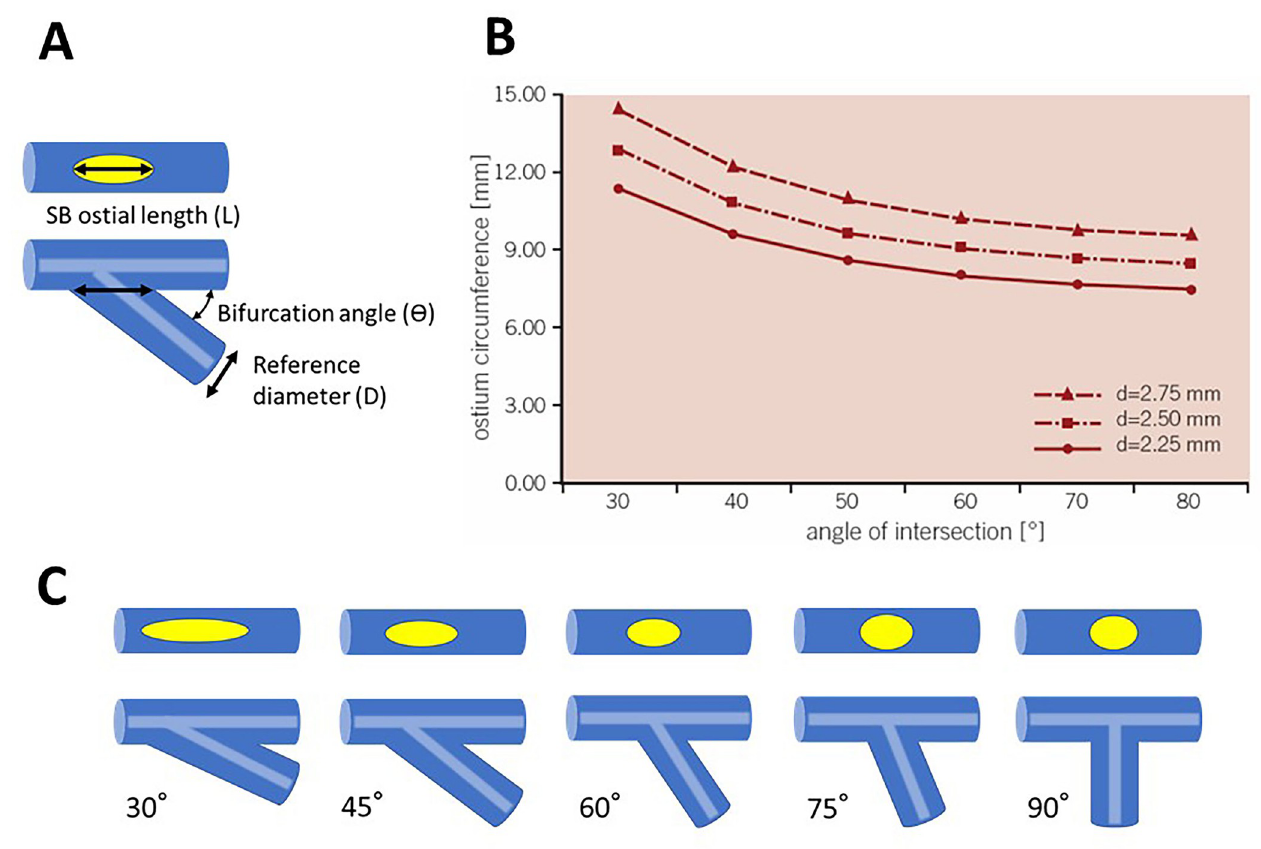
Fig 3. Relation between bifurcation angle (BA) and side branch (SB) ostial geometry. (A) Relation among BA ( θ ), SB ostial length (L) and reference diameter (D). See detail in text. (B) SB ostial circumferential length. Narrower BA is associated with longer length. Adapted from reference no. 36. (C) SB ostial shape. Narrower BA is associated with elliptical change in SB ostial